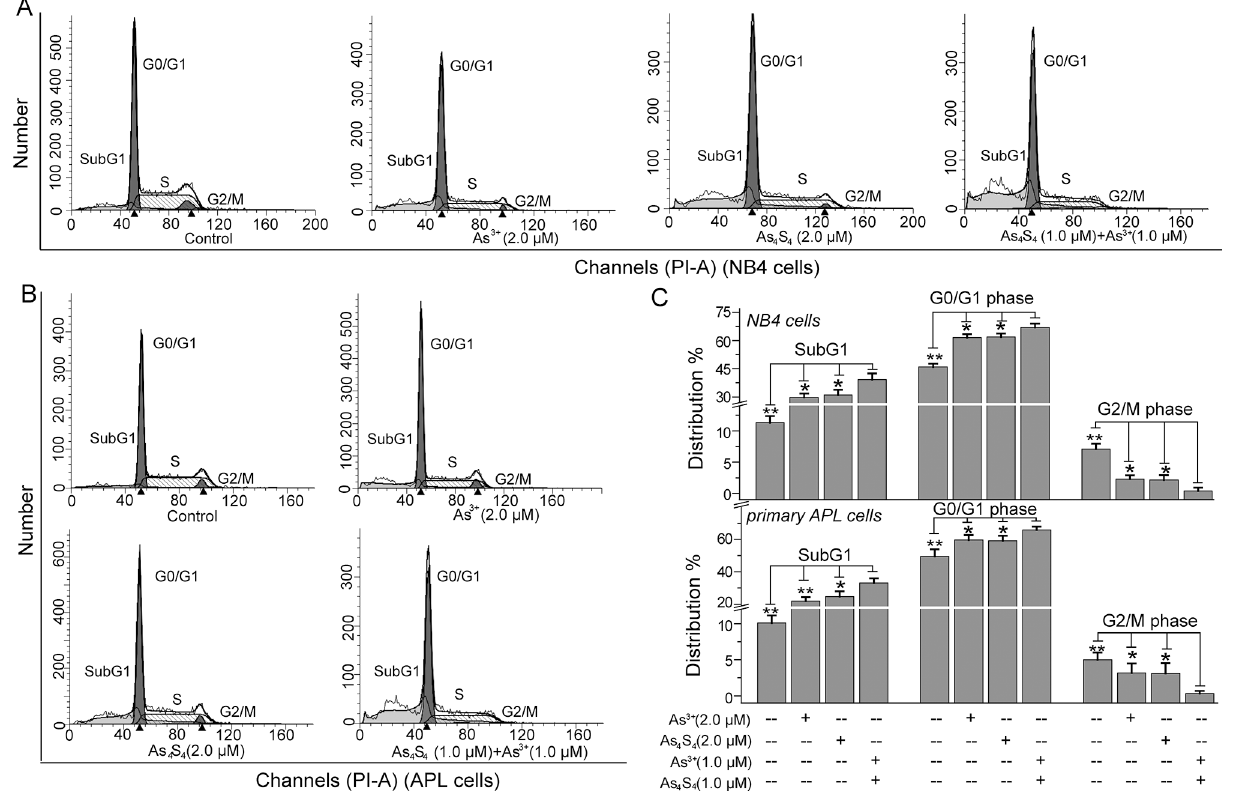
Fig 3. The effects of combining As 3+ and As 4 S 4 on cell cycle distribution. (A) Cell cycle distribution in NB4 cells. (B) Cell cycle distribution in primary APL cells. (C) The percentage of cell cycle distribution in each phase. After 48 h of treatment, NB4 and primary APL cells were stained with PI and analyzed by flow cytometry. Figures show a representative experiment of three independent experiments. * P < 0.05 and ** P < 0.01 compared with As 3+ and As 4 S 4 combination treated cells.